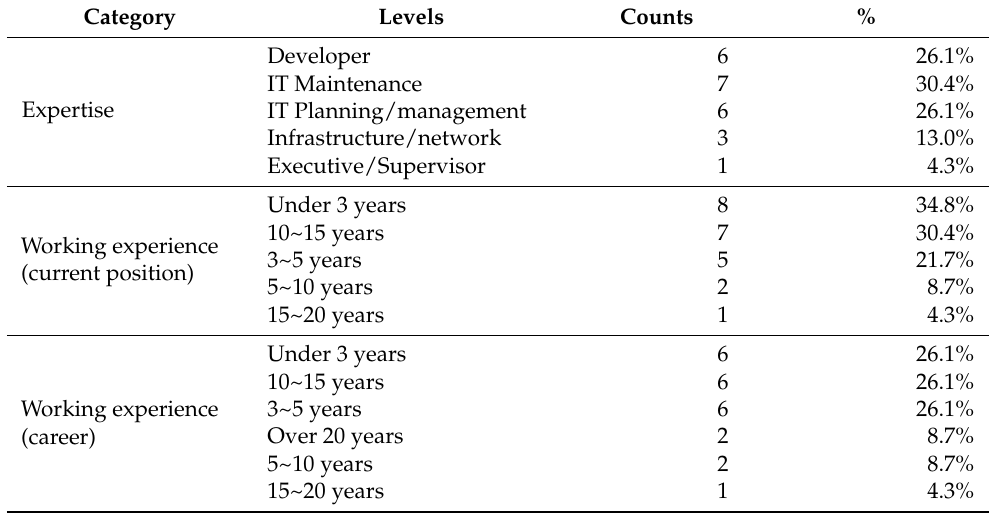
Table 3. Descriptive statistics of